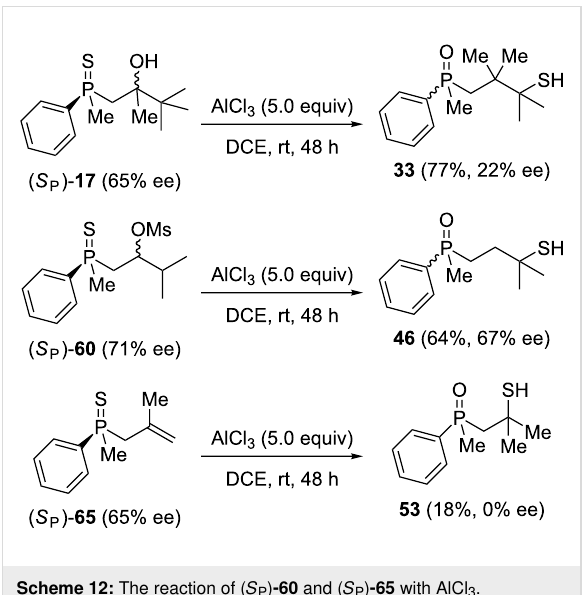
Scheme 12: The reaction of ( S P ) -60 and ( S P ) -65 with AlCl 3 .